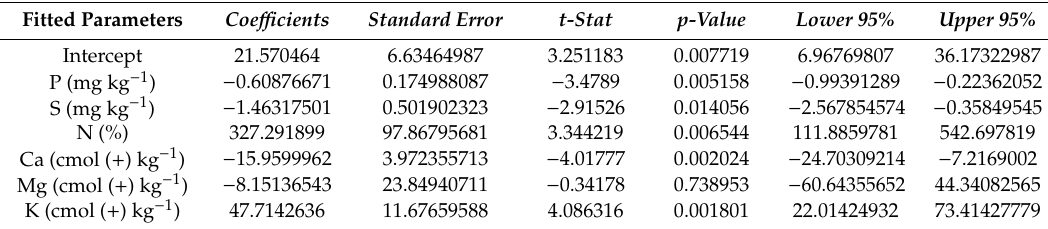
Table 3. A multiple linear regression analysis of nicotine as a response parameter and the measured macronutrients in soils.